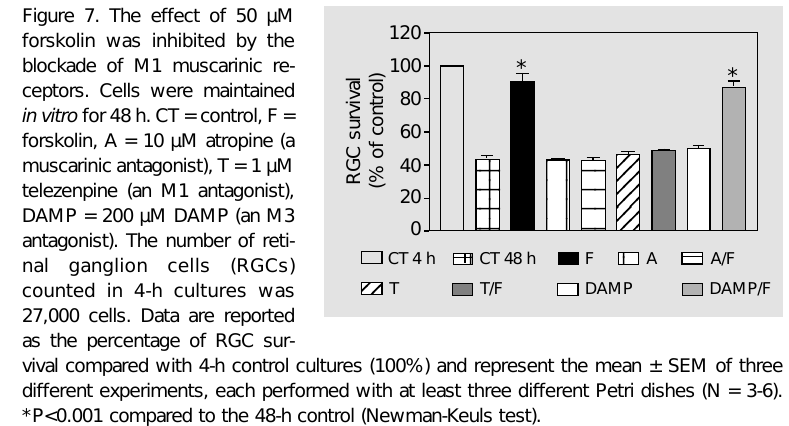
Figure 6. The effect of 50 µM forskolin was blocked by 20 µM FDUR. Cells were maintained in vitro for 48 h. CT = control, F = forskolin, FDUR = 5-fluoro-2'-de- oxyuridine (inhibitor of cell prolif- eration). The number of retinal ganglion cells (RGCs) counted in 4-h cultures was 18,000 cells. Data are reported as the percent- age of RGC survival compared with 4-h control cultures (100%) and represent the mean ± SEM of two different experiments, each performed with at least three different Petri dishes (N = 3-6). *P<0.001 compared to the 48-h control (Newman-Keuls